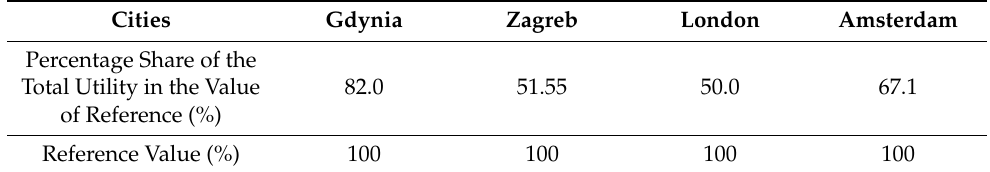
Table 6. Percentage share of the total utility with regard to reference value.